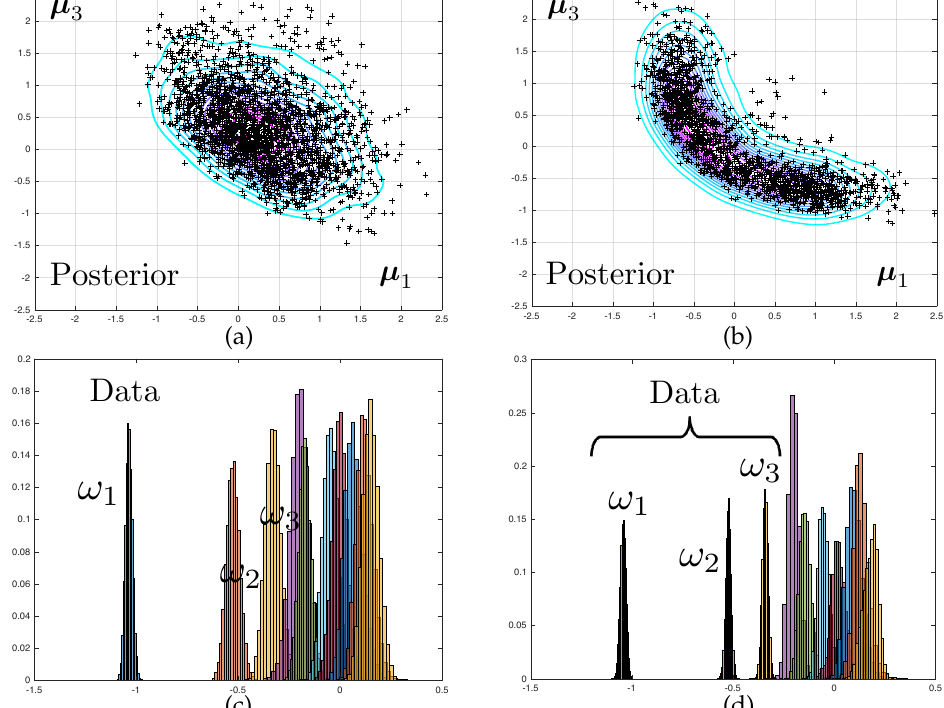
Figure 3. ( a ) Joint posterior probability distribution for two of the 6 unknown elastic modulii and ( c ) marginal posterior predictive distributions of the first 10 free vibration frequencies. The data set consists of a noisy measurement of the first frequency only, resulting in fat posterior densities. ( b ) Posterior distribution of the two unknown elastic modulii when the first 3 vibration frequencies are used as dataset, which results as in much thinner posterior densities. ( d ) Corresponding posterior predictive